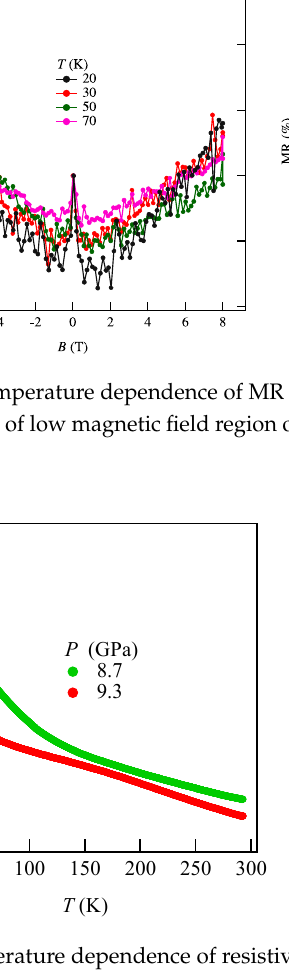
Figure A4. Temperature dependence of resistivity (sample 9).